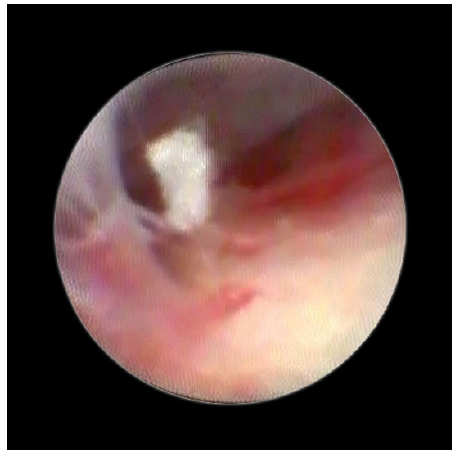
Figure 4. Fibrotic septum in epidural space.